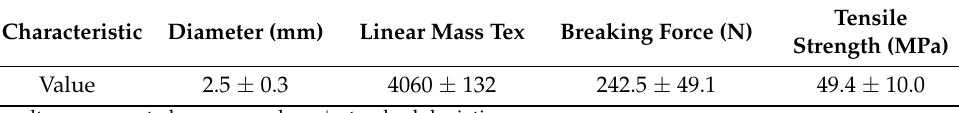
Table 9. Characteristics of the optimal 100% linseed flax yarn, i.e., corresponding to 100 twists per